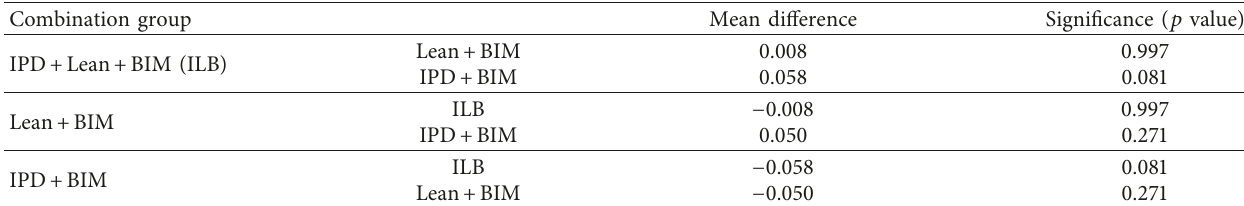
Table 5: Pairwise comparisons of combination groups in terms of schedule performance.